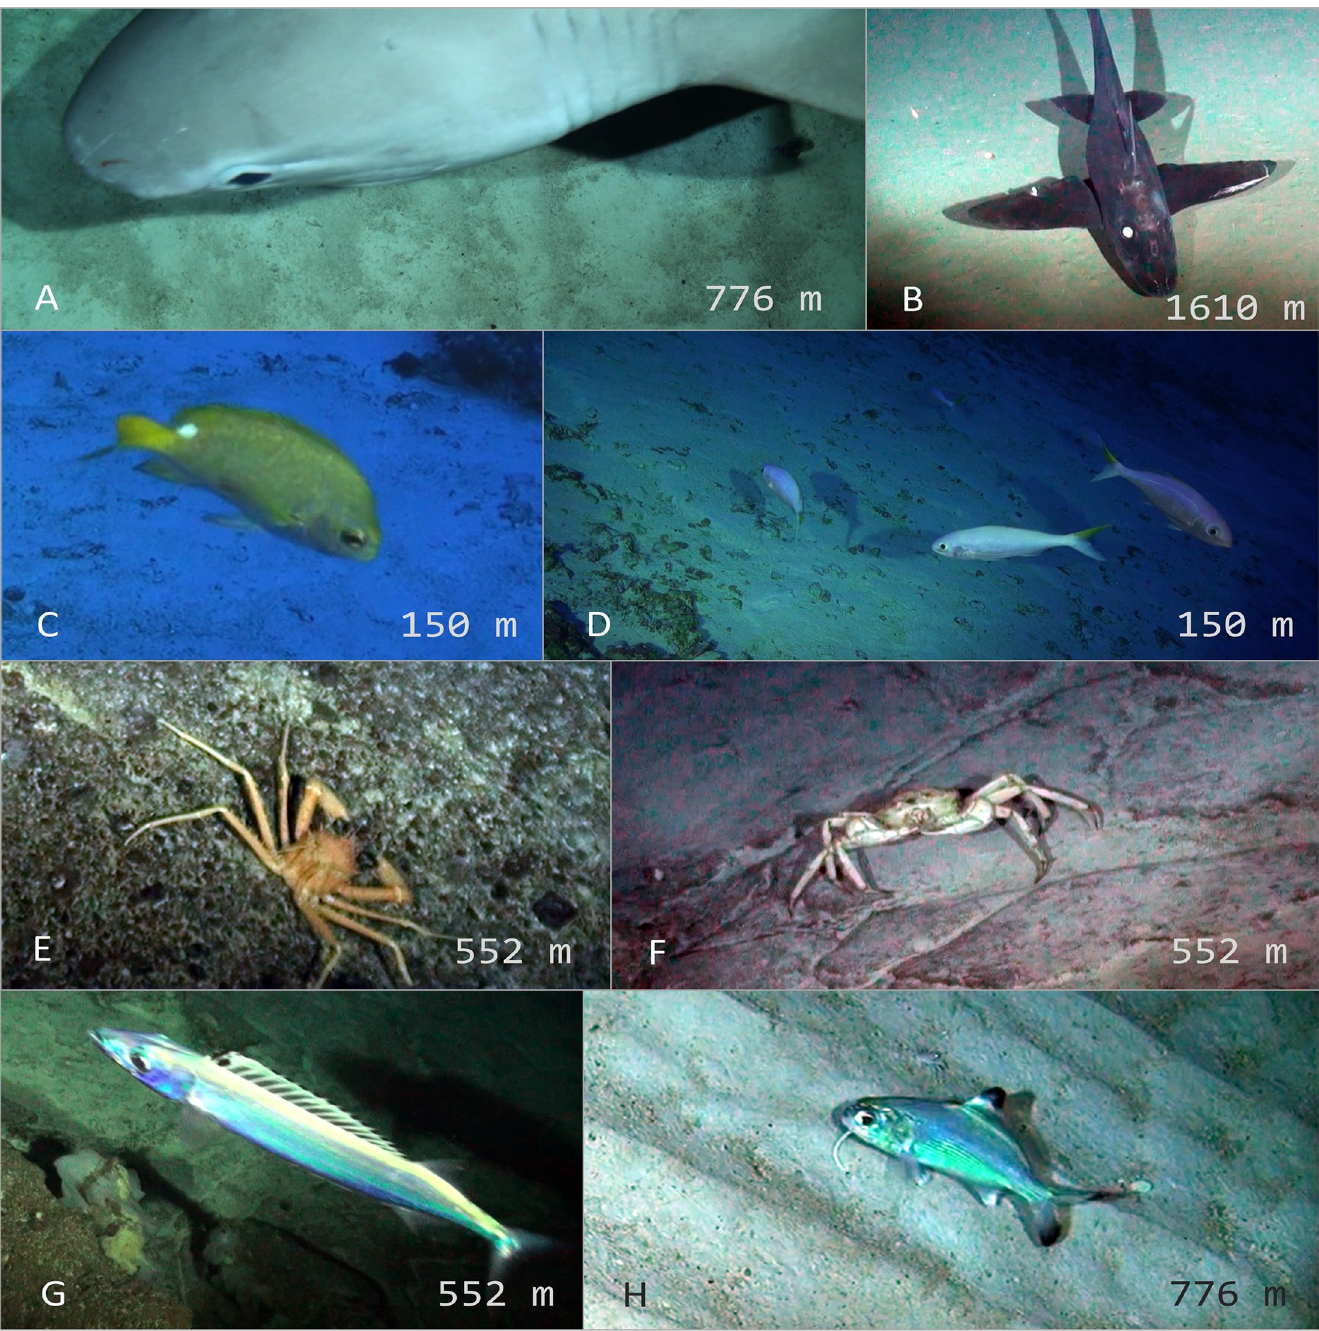
Fig 2. Representative and unique taxa observed with deep-sea camera systems around Rapa Nui and Salas y Go´mez islands. (A) Hexanchus griseus (B) Hydrolagus melanophasma (C) Chromis mamatapara � (D) Parapristipomoides squamimaxillaris (E) Homolidae, Yaldwynopsis sp. (F) Geryonidae (G) Rexea sp. (H) Polymixia salagomeziensis � . � endemic